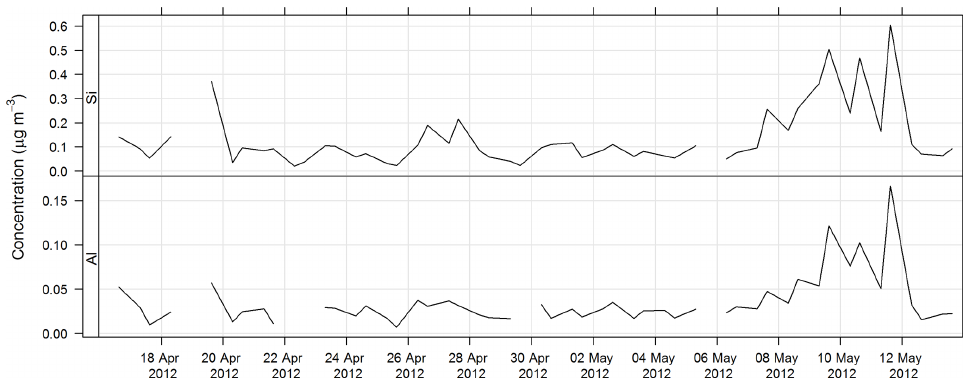
Figure 16. Time series of Al and Si during SPS-II.